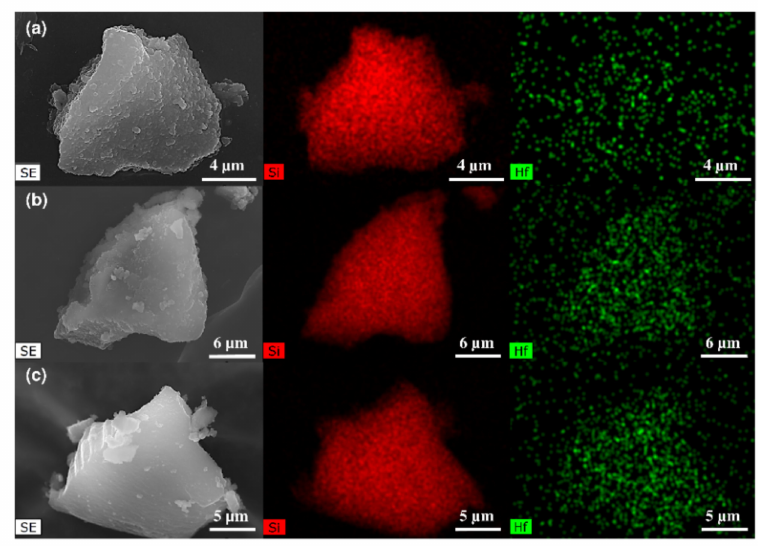
Figure 1. SEM images and elemental maps (Si—red, Hf—green) of Hf-TUD-1(75) ( a ), Hf-TUD-1(50) ( b ), and Hf-TUD-1(25) ( c ).